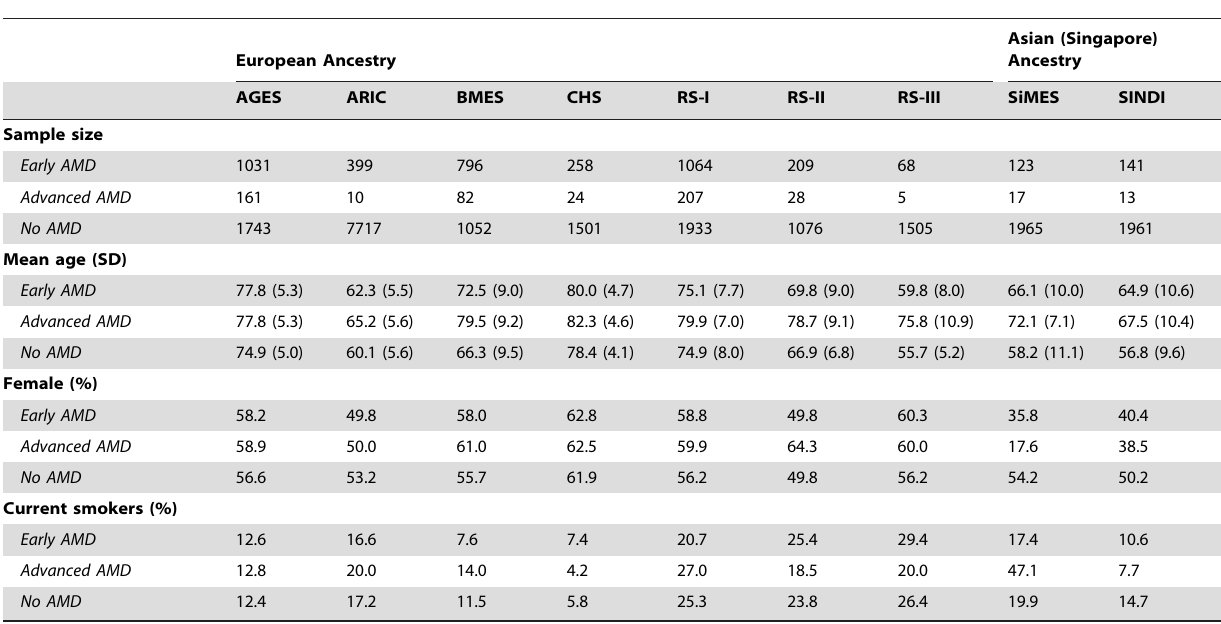
Table 1. Population characteristics for the individual cohorts.